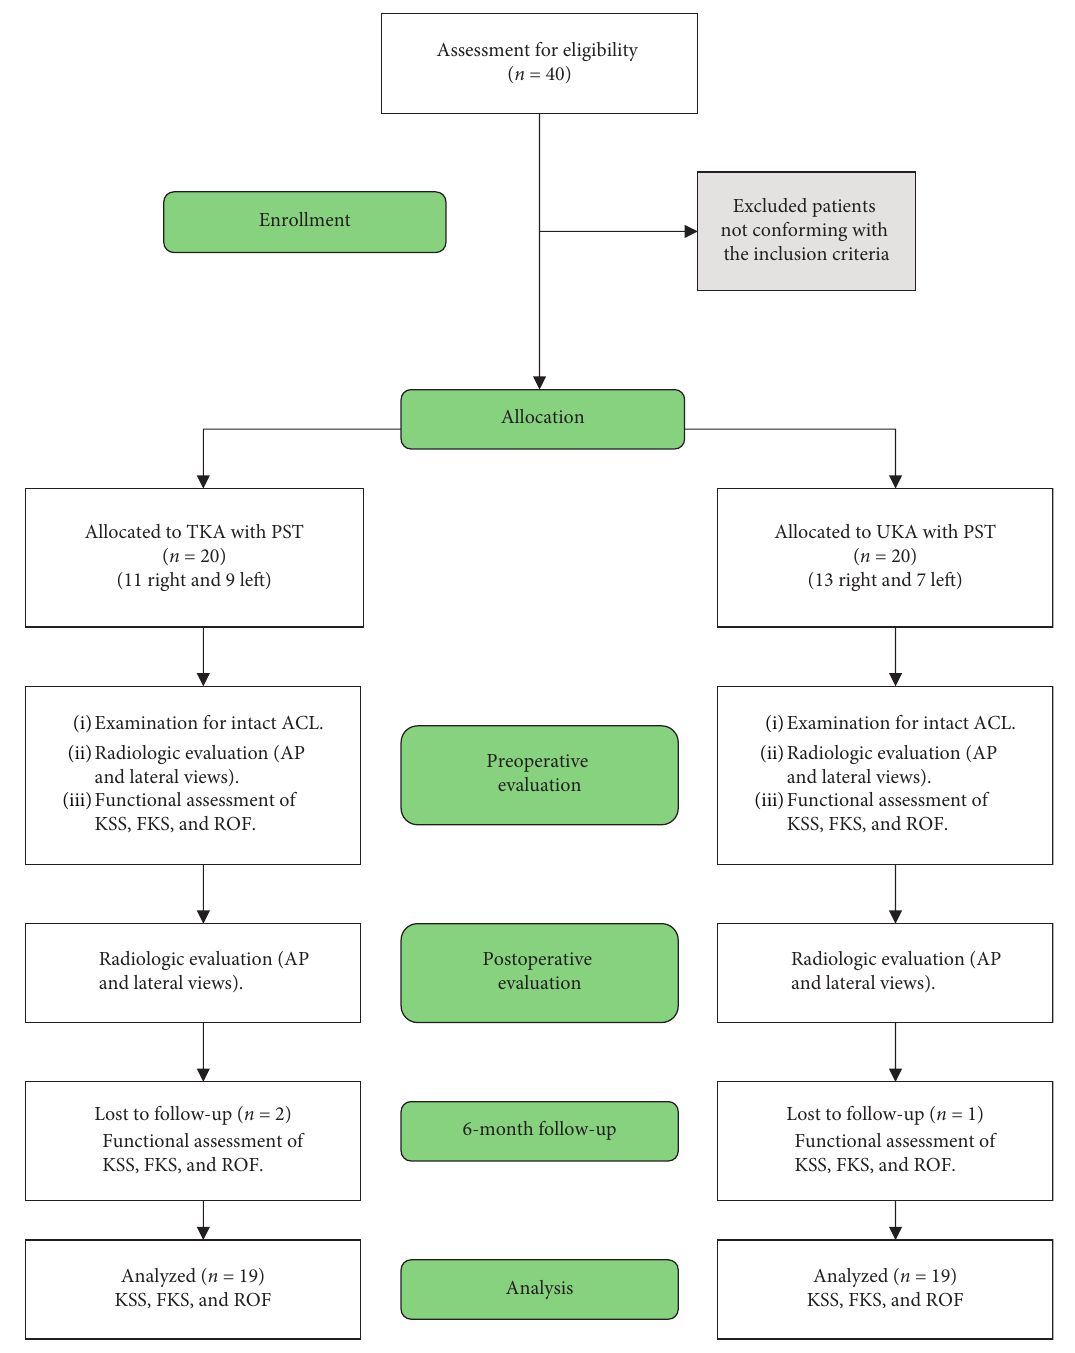
Figure 1: Flow diagram showing the recruitment process in the study. TKA, total knee arthroplasty; UKA, unicompartmental knee arthroplasty; PST, patient-specific templating; AP, anteroposterior; KSS, knee society score; FKS, functional score of knee society score; ROF, range of